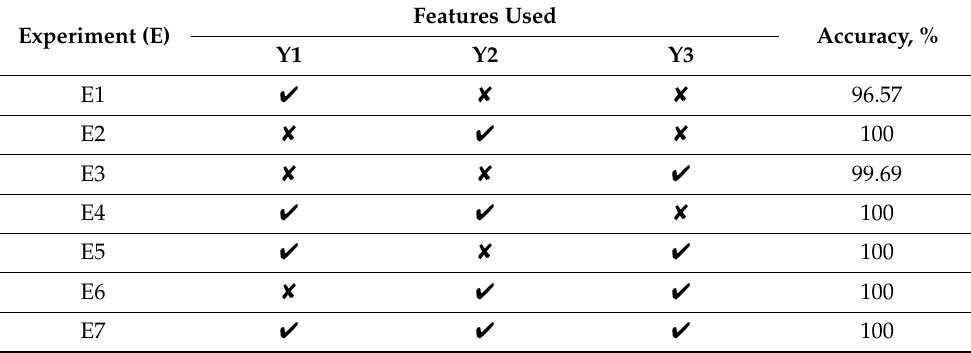
Table 4. Summary of the experiments conducted to find the strength of feature combinations in classifying machine